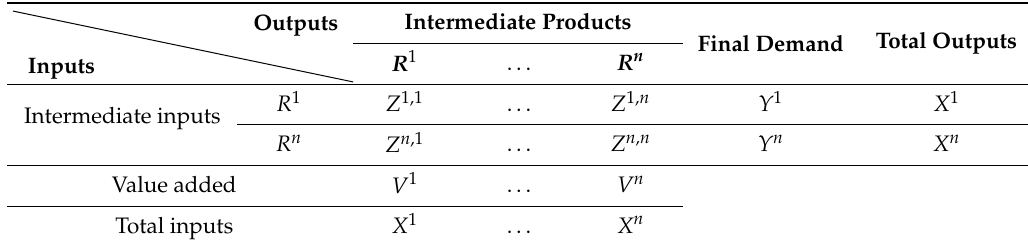
Table 1. The structure of the multi-regional input-output